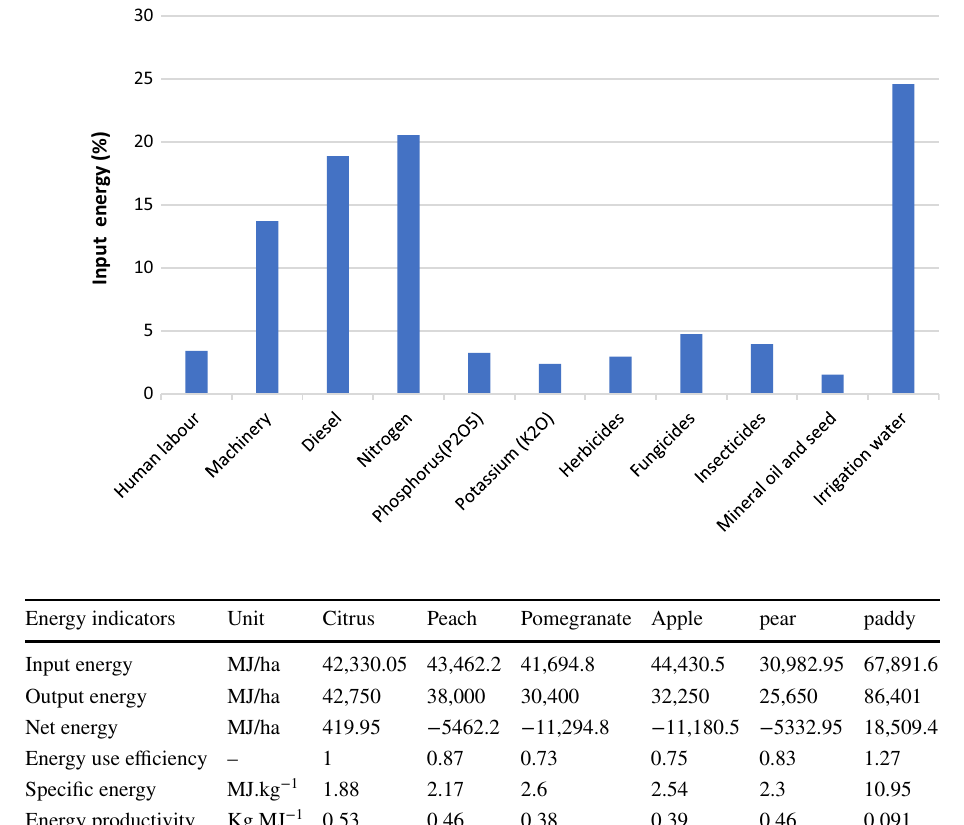
in the production of studied products in the Tajan plain